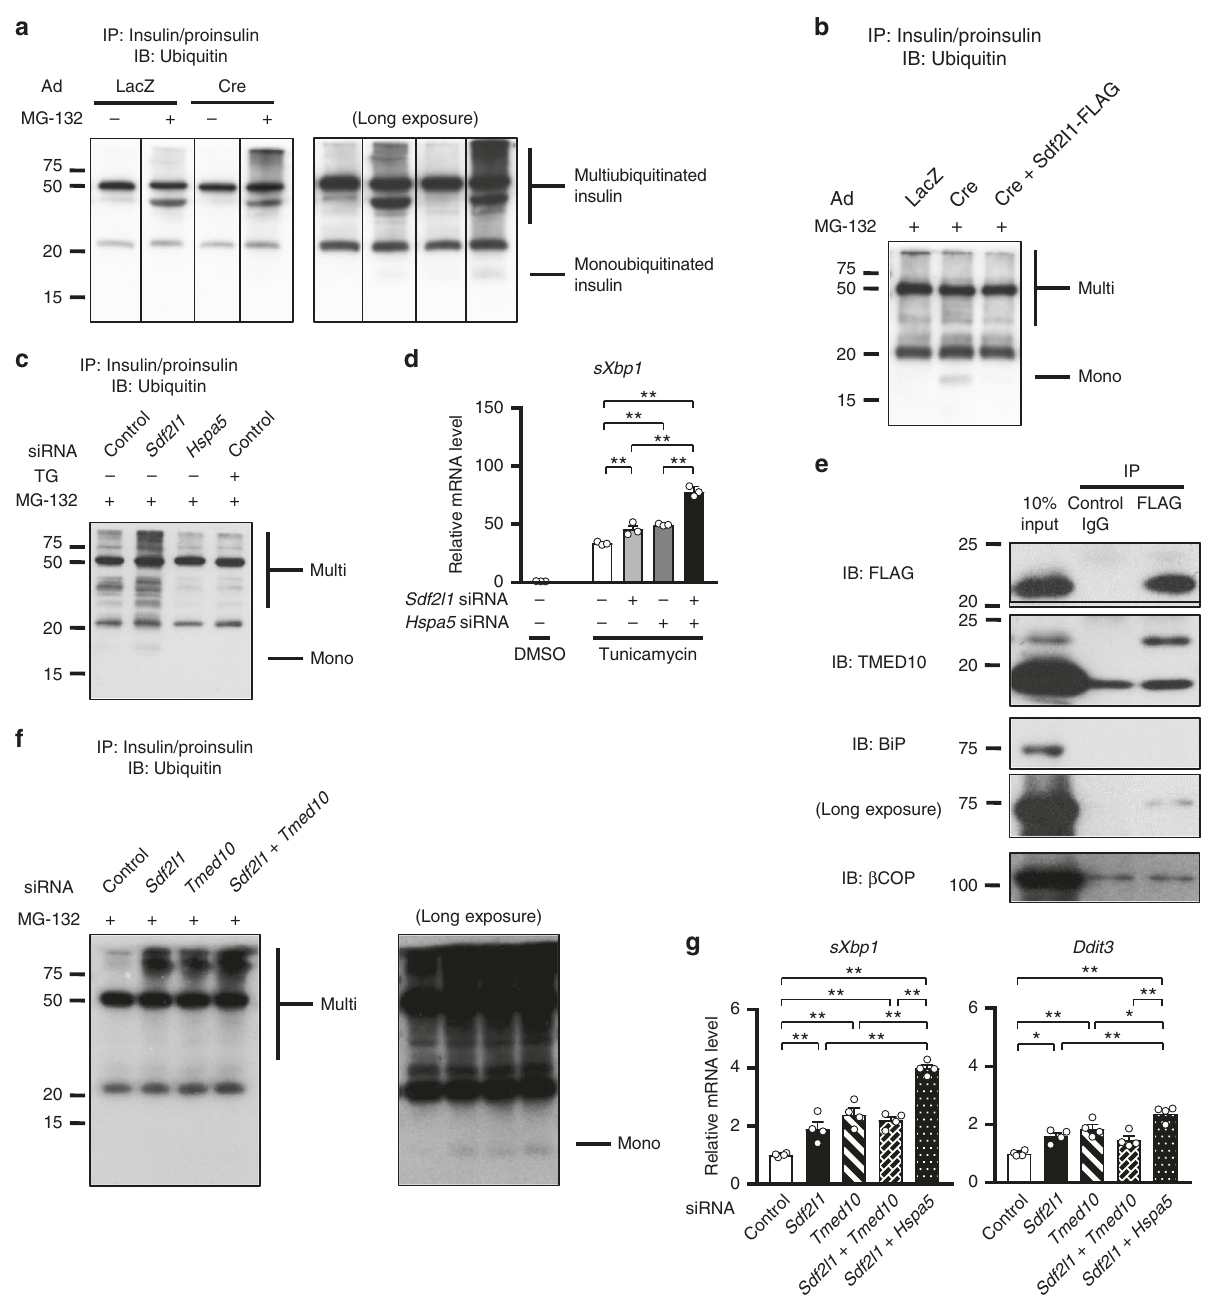
Fig. 2 Functions of Sdf2l1 in vitro. a – c , f Cultured cells were infected with Ad-Ins C96Y , whose lysates were immunoprecipitated for Western blotting: a , b Sdf2l1 - fl oxed MEF cells, with a co-infection of Ad-Cre to knock out Sdf2l1 , and with b further co-infection of Ad-Sdf2l1-FLAG to restore the expression; c NIH/3T3 cells, with either Sdf2l1 or Hspa5 knocked down, or with treatment with thapsigargin for 6 h; f primary hepatocytes, with Sdf2l1 or Tmed10 knocked down. In a , the lanes were run on the same gel but were noncontiguous. Multi: multiubiquitinated insulin, Mono: monoubiquitinated insulin. d RT- PCR to analyze ER stress marker gene expression in NIH/3T3 cells with Sdf2l1 and/or Hspa5 knocked down, treated with tunicamycin treatment ( n = 3). e Wild-type mice were administered with Ad-Sdf2l1-FLAG intravenously (2.0 × 10 7 PFU/g body weight [BW]), and refed for 6 h after fasting for 24 h, whose microsomal fractions were immunoprecipitated for Western blotting. g RT-PCR to analyze ER stress marker gene expression in primary hepatocytes, with ER-resident molecule(s) knocked down, treated with 100 nM insulin for 2 h after serum starvation for 16 h ( n = 4). Values of the data are expressed as mean ± SEM. * P < 0.05, ** P < 0.01. One-way ANOVA was used for